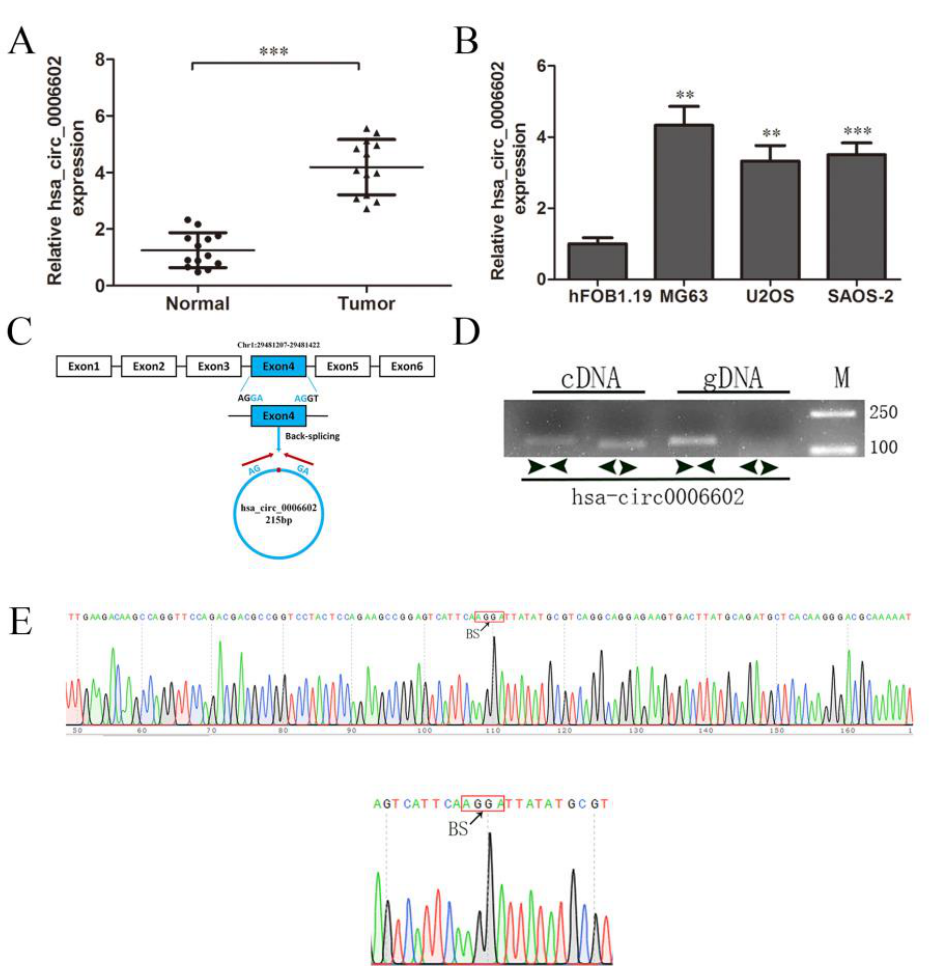
Figure 1. Characterization and expression of hsa_circ_0006602 in OS tissues and cell lines. ( A ) Relative expression of hsa_circ_0006602 in OS tissues and corresponding paracancerous tissues ( n = 13). ( B ) Relative expression of hsa_circ_0006602 in OS cell lines. ( C ) Head-to-tail splicing junction in hsa_circ_0006602. ( D ) Amplification of hsa_circ_0006602 using cDNA and gDNA as templates in MG63 cells; GAPDH was used as a negative control. ( E ) Sequencing analysis of hsa_circ_0006602. *P <0.05, ** P <0.01, ***P <0.001.